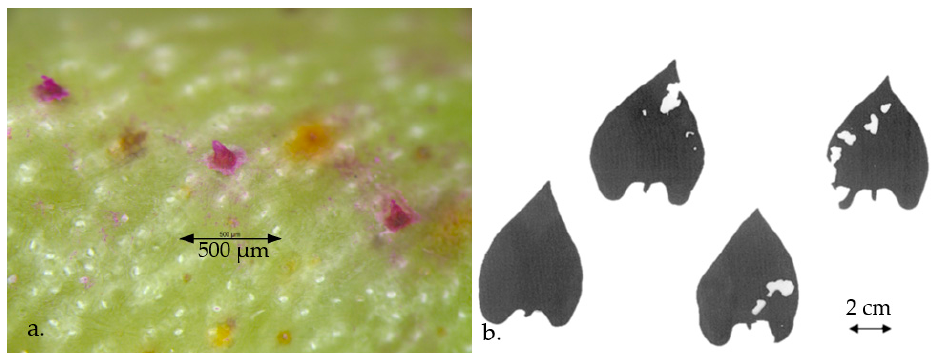
Figure 12. Stylet sheath (violet dots) indicates food activity damage to bean pods by E. heros ( a ); white holes in the leaves indicate leaf consumption by D. speciosa ( b ) .